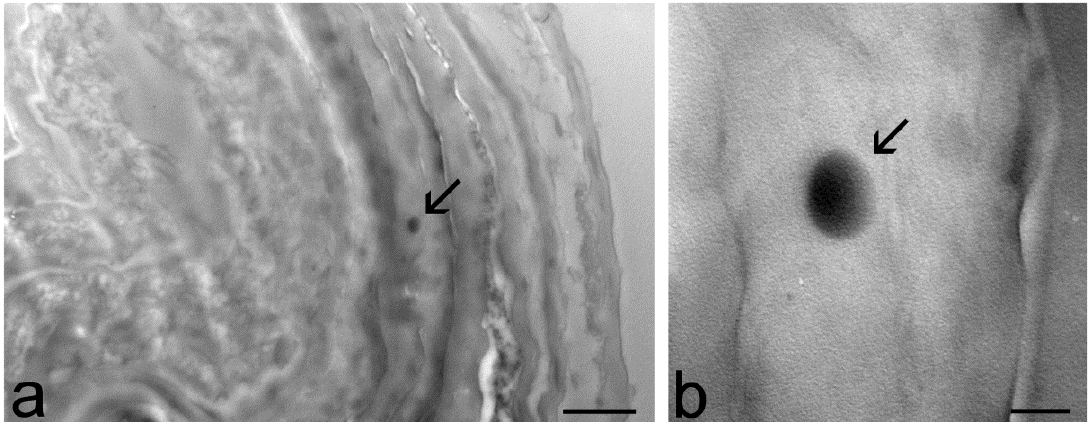
Figure 6. TEM micrographs of a TET-2 (arrows) inside a corneocyte of the outer layer of the skin ( a ). ( b ) High-magnification detail: note the homogeneous dark content of the vesicle. Bars: 1 µm ( a ); 200 nm ( b ).